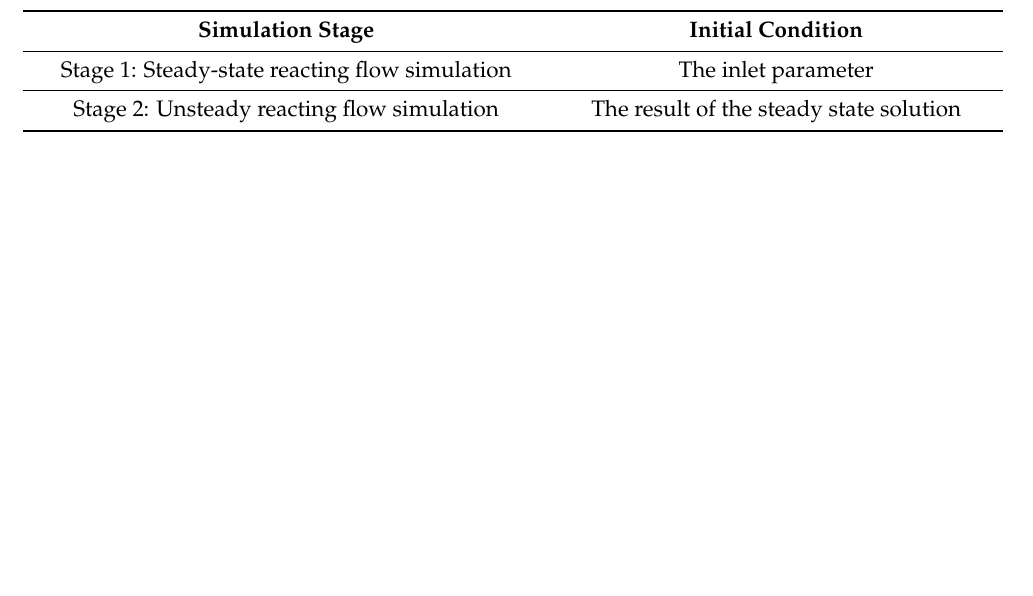
Table A2. Operational conditions for the Rijke burner